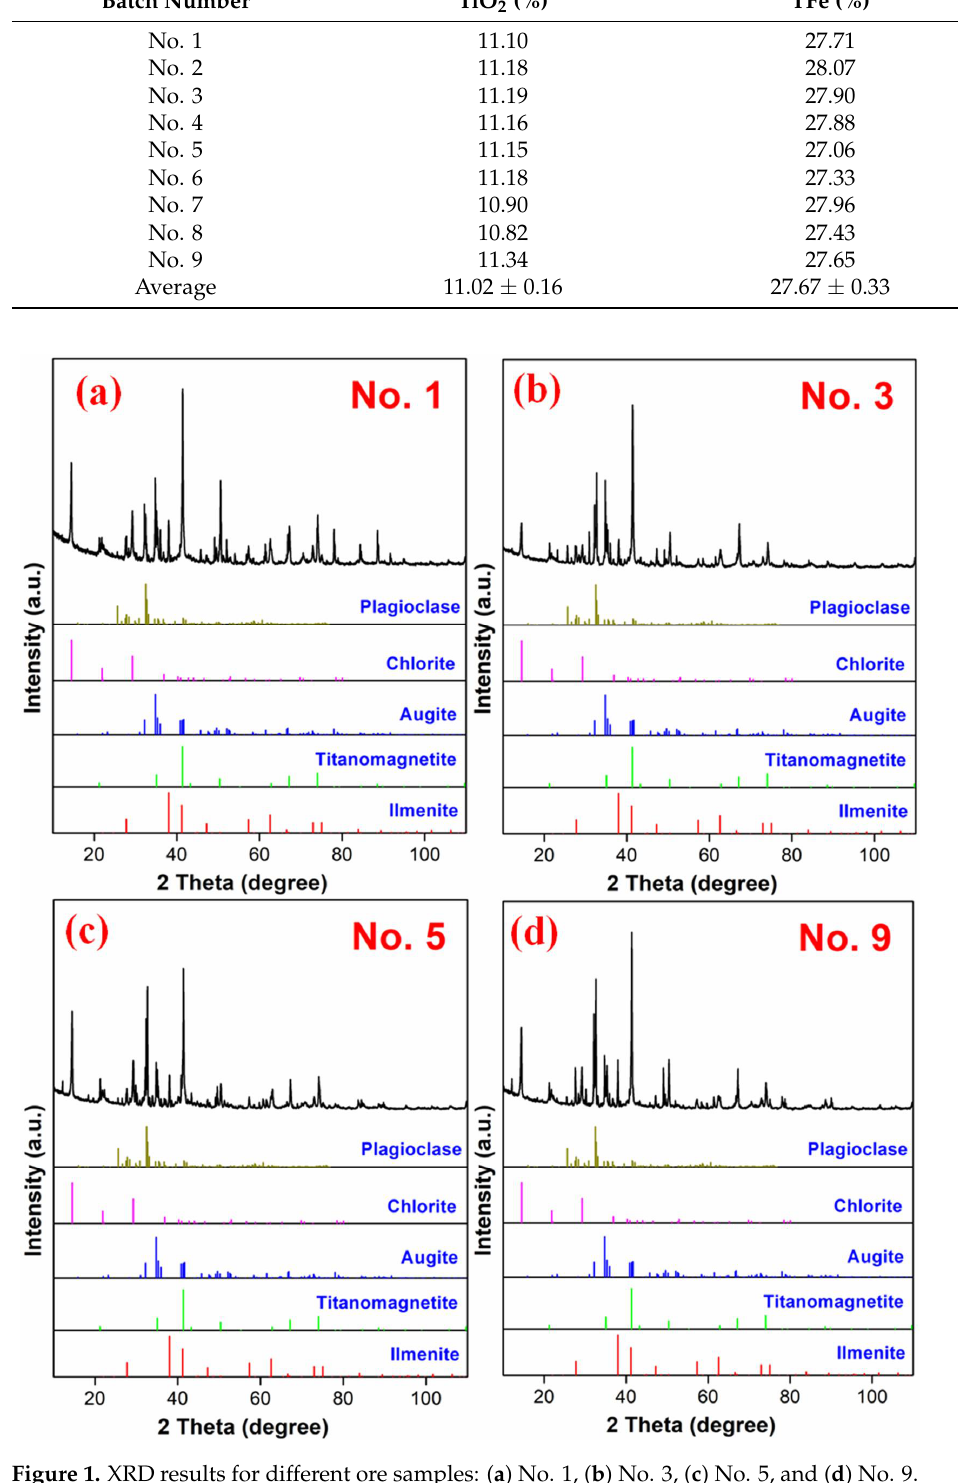
Figure 2. ( a ) Appearance and ( b ) particle size distribution of the ore samples.